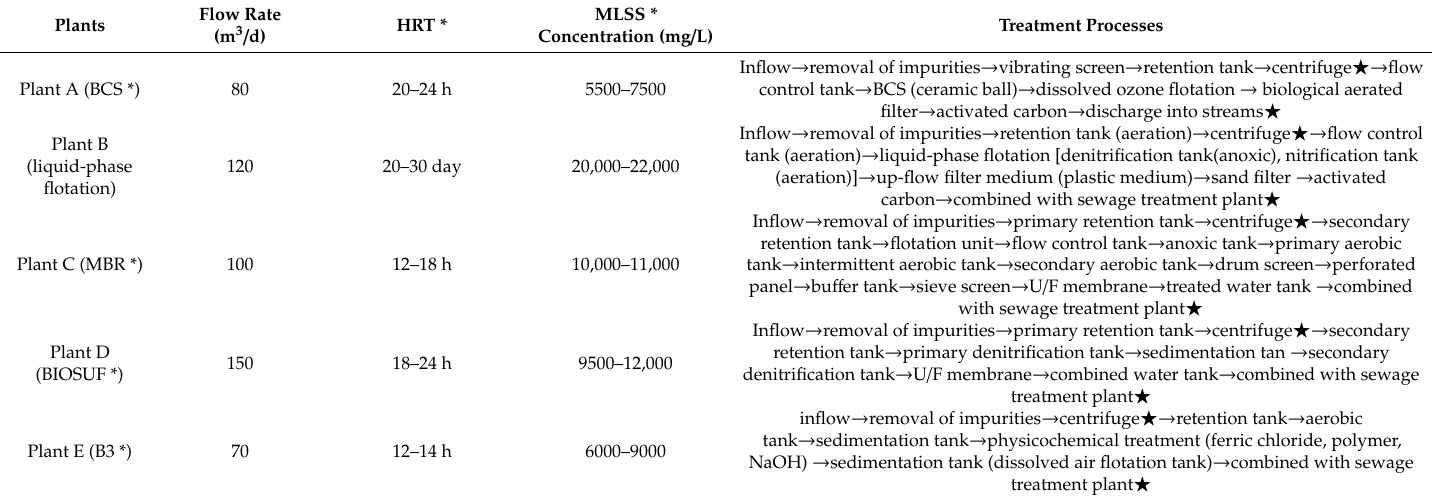
Table 3. Characteristics, treatment processes and sampling sites for di ff erent livestock wastewater